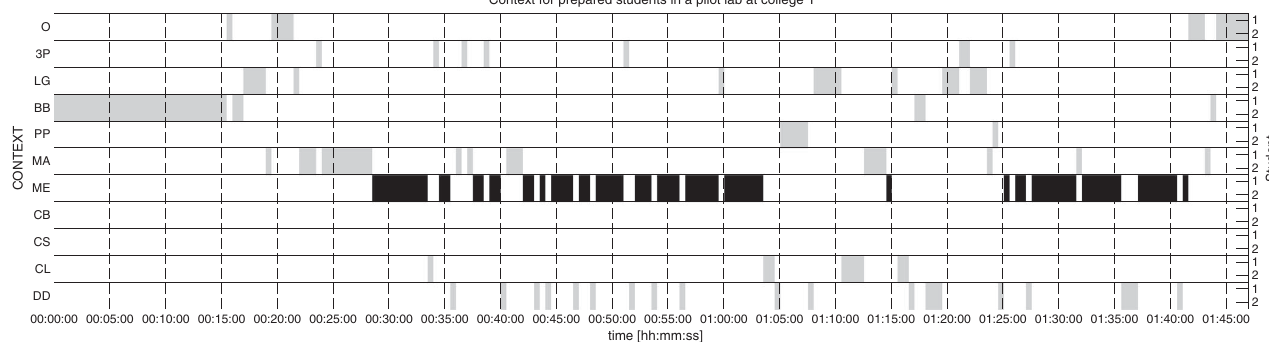
FIG. 7. Time lines for unprepared (top) and prepared (bottom) students in the pilot version of the new laboratory. Each line represents a context category and a block means that the activity represented by a context is done by the students. The highlighted line indicates the measurement context (ME). It is one more or less continuous block of measurements for the unprepared students, while there are two distinct clusters for the prepared